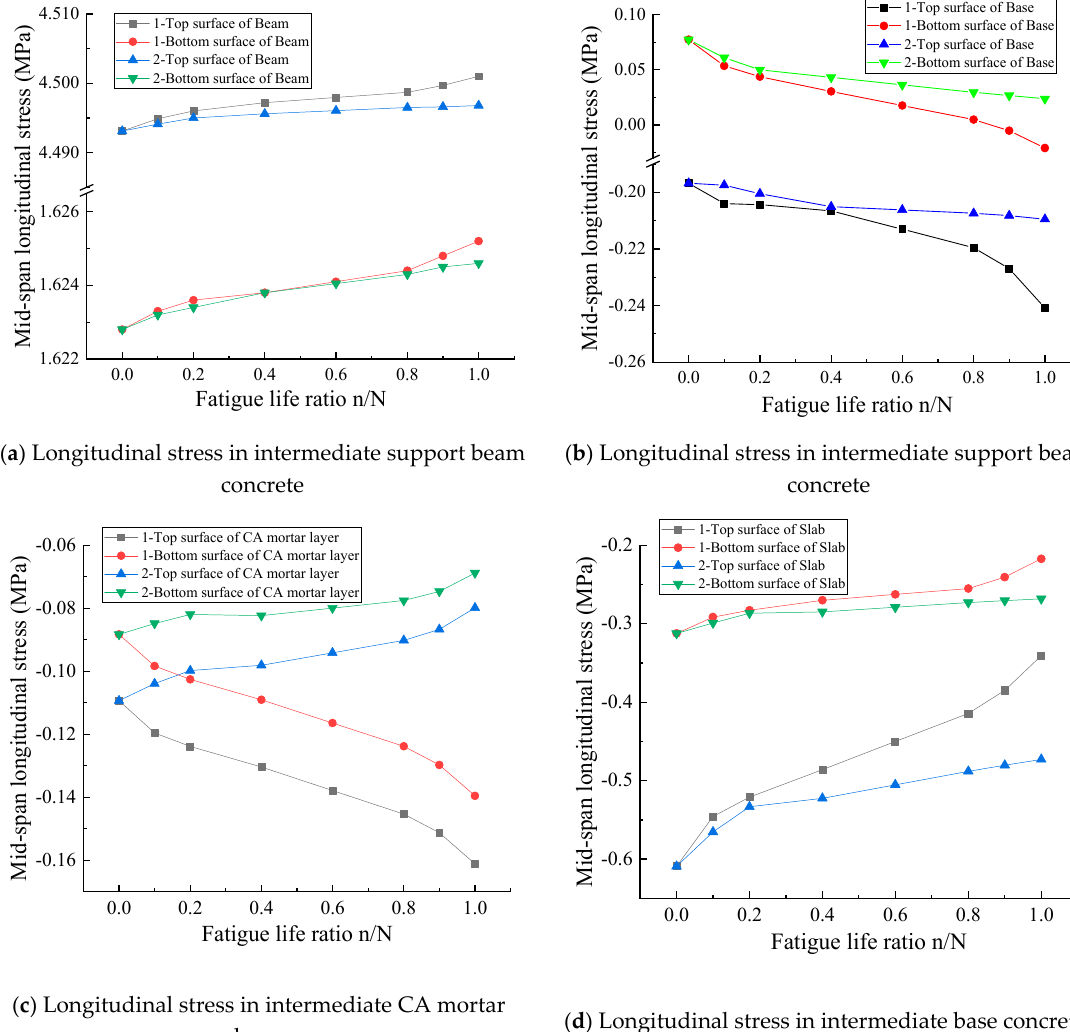
Figure 18. Longitudinal stress of structural parts considering or regardless of CA mortar layer